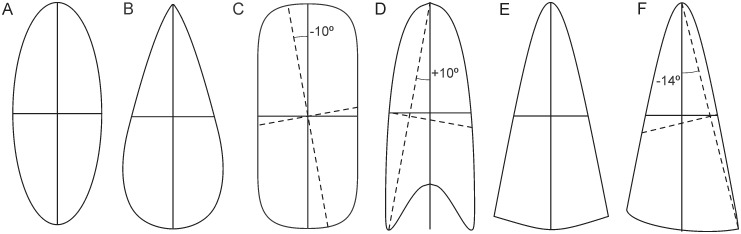
Idealized LSB shapes.A) elliptical; B) half-lemniscate (oval); C) stadium; D) parabolic with symmetric crescentic lee; E) hyperbolic with symmetric convex lee; F) hyperbolic with asymmetric convex lee. A and C have 2 axes of symmetry; B, D and E have 1 axis of symmetry. Inside the shapes: solid lines represent the reference longitudinal axis and its perpendicular bisector; dashed lines in C, D and F are the longest straight line and its perpendicular bisector. Angles in C, D and F represent the difference in orientation between the reference LA and the longest straight line.